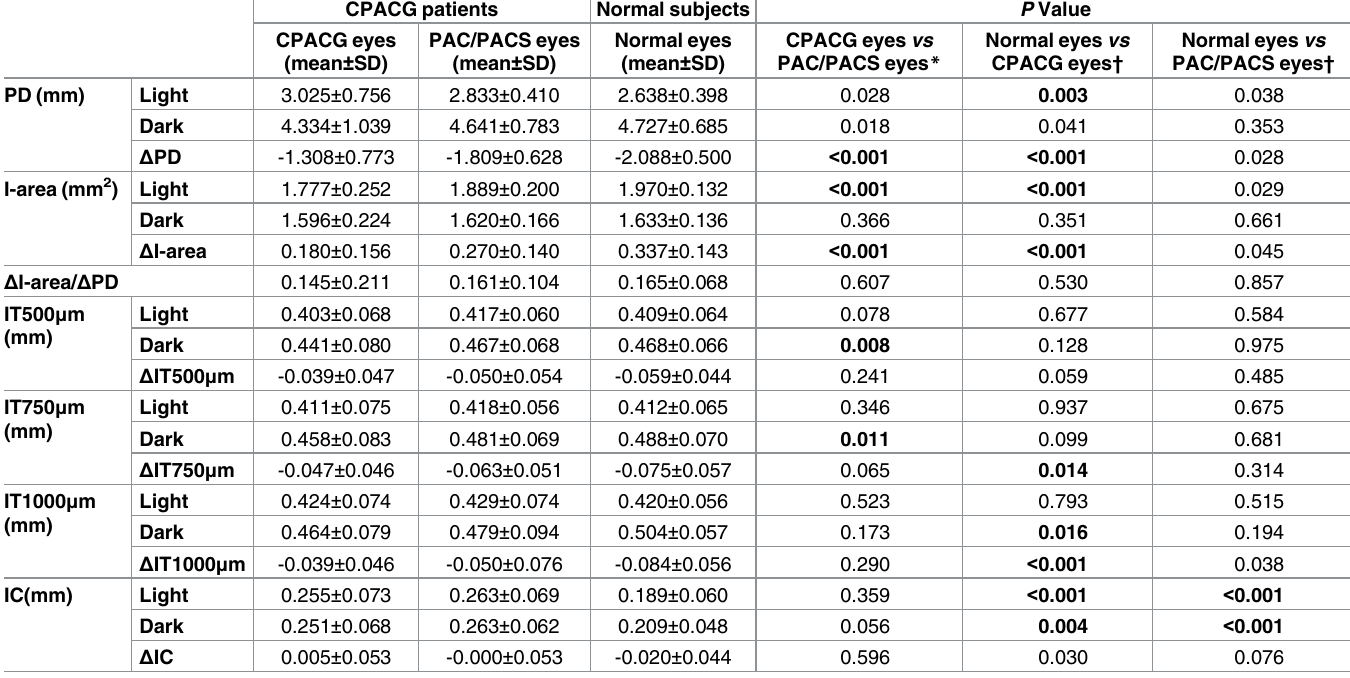
Table 3. Iris parametersunder light/dark conditions and changes ( Δ ) in CPACG patients (CPACG eyes vs fellow PAC/PACS eyes) and normal